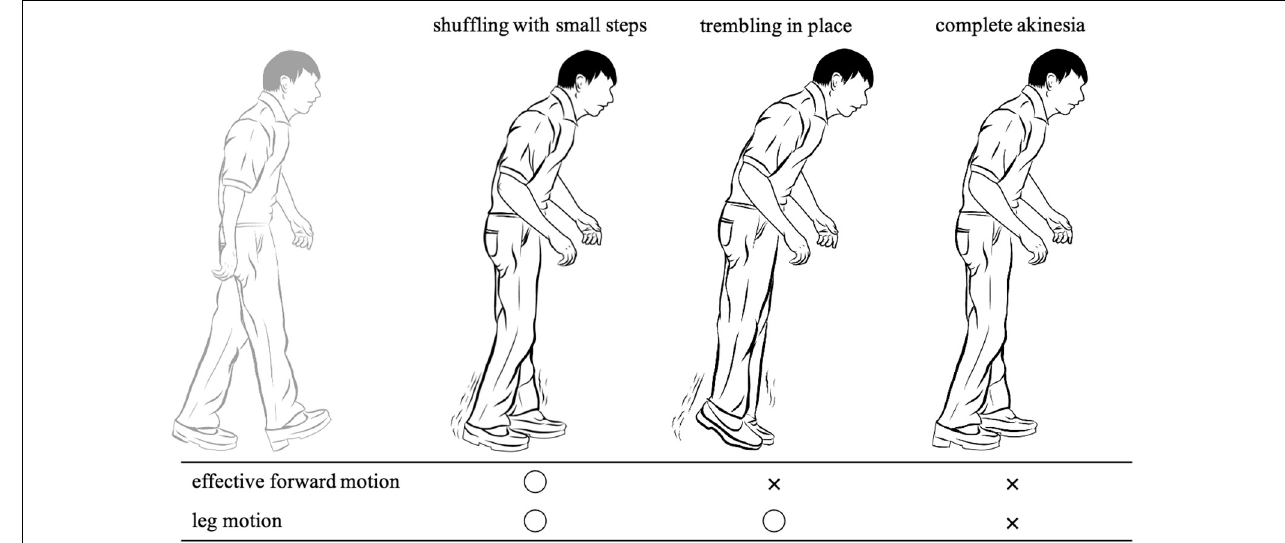
FIGURE 1 | Three phenotypes of freezing of gait according to leg movements.